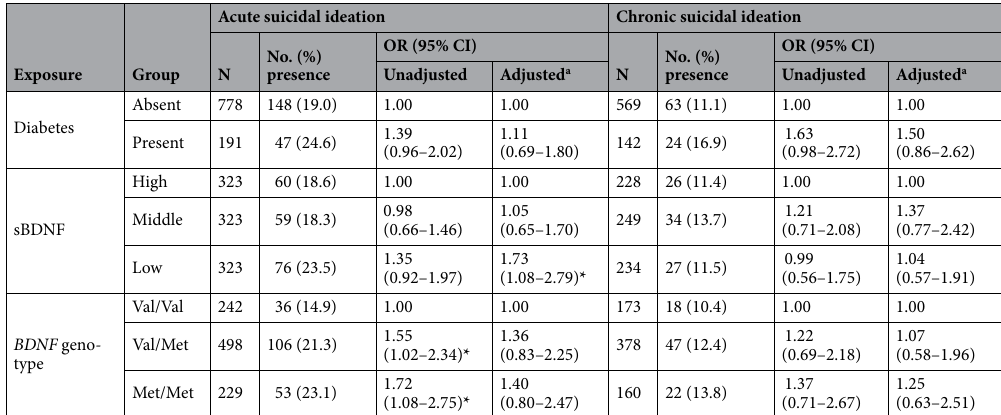
Table 2. Individual effects of diabetes, BDNF Val66Met polymorphism, and tertiles of serum BDNF levels on acute and chronic suicidal ideation in patients with acute coronary syndrome. a Adjusted for age, sex, education, housing, current unemployment, previous depression, BDI score, hypertension, hypercholesterolemia, current smoking, and LVEF. BDNF, brain-derived neurotrophic factor. * P <